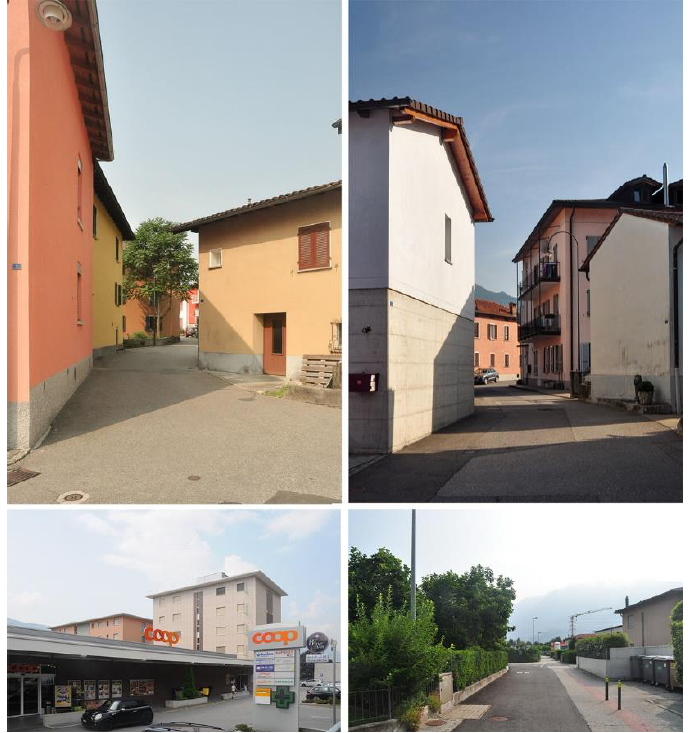
Figure 7. Typical space of Monte Carasso (above) and Sementina (below). It is clear that in the former case the built fabric contributes to demarcation of public space and creates much “richer” relations [56], while in the latter case, the relationship between buildings and space between them is merely functional. Source: Author.